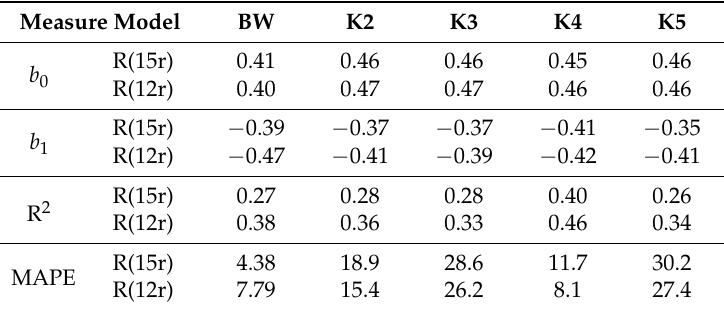
Table 6. Statistical summary for each card in two variants (models).